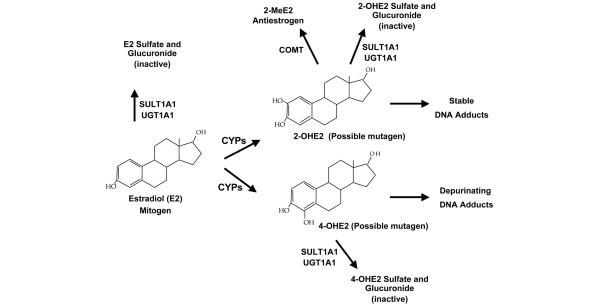
Disposition of 17β-estradiol (E2) and metabolites. SULT1A1 and UGT1A1 inactivate E2, and thus represent an antimitogenic pathway; the products of E2 oxidation, 2-hydroxyestradiol (2-OHE2) and 4-hydroxyestradiol, (4-OHE2), are both possible mutagens; 2-OHE2 is methylated by catechol-O-methyltransferase (COMT) to the antiproliferative compound 2-methoxyestradiol (2-MeE2), thus this pathway is potentially both antimutagenic and anitmitogenic. 2-OHE2 is alternatively sulfated and glucuronidated; this pathway would be predicted to be antimutagenic because it inactivates 2-OHE2 and, at the same time, promitogenic because it competes with the antimitogenic methylation pathway. 4-OHE2 is also inactivated by SULT1A1 and UGT1A1. Thus, sulfation and glucuronidation, depending on the cellular context and the competing metabolic pathways in a specific cell, may represent protective (detoxifying) or detrimental pathways. CYPs, Cytochromes P450.